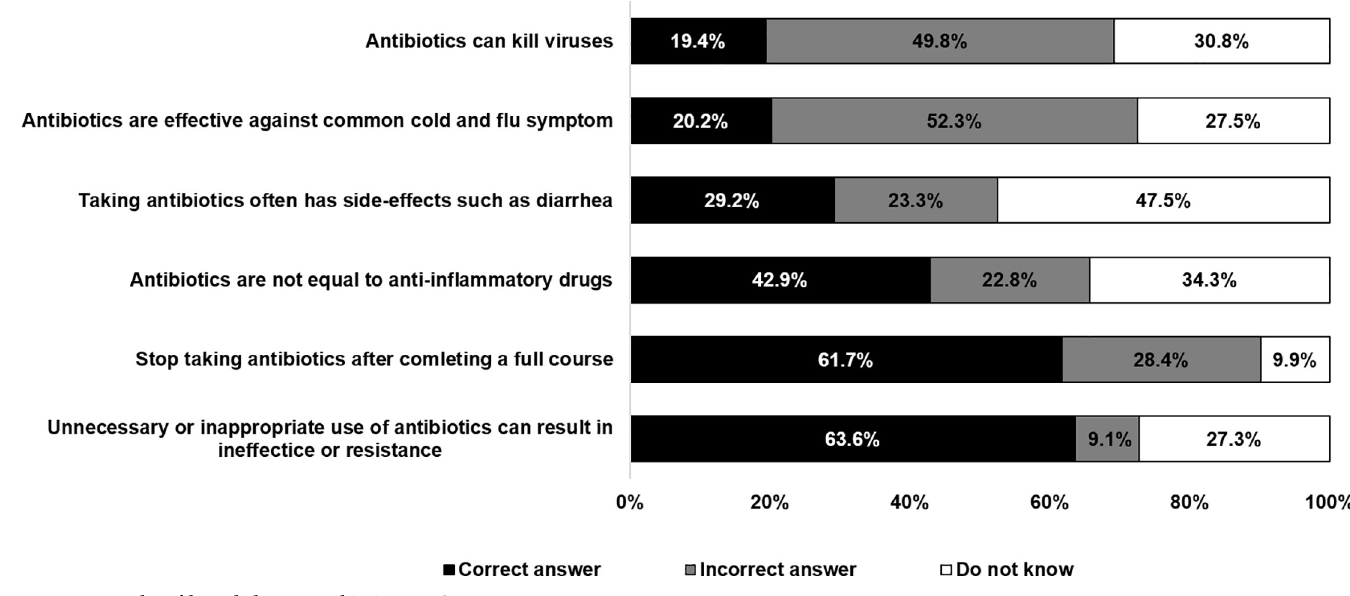
Fig 2. Respondents’ knowledge on antibiotics, HWS 2017.